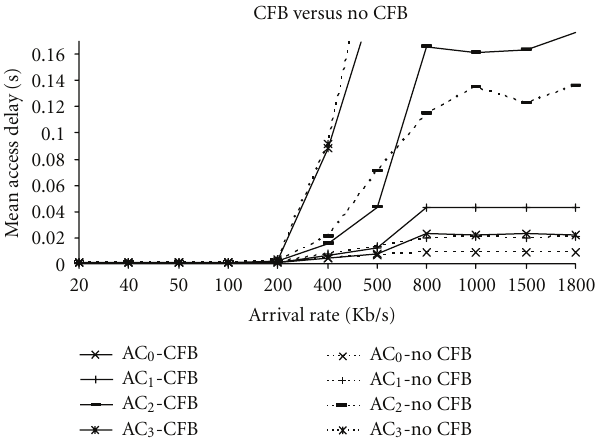
Figure 5: E ff ect of CFB on the access delay per AC.